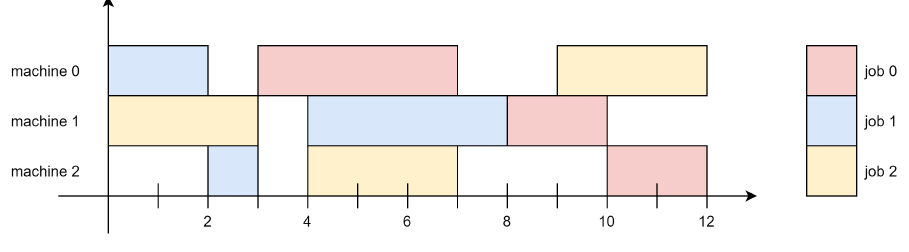
Figure 2. Job shop scheduling